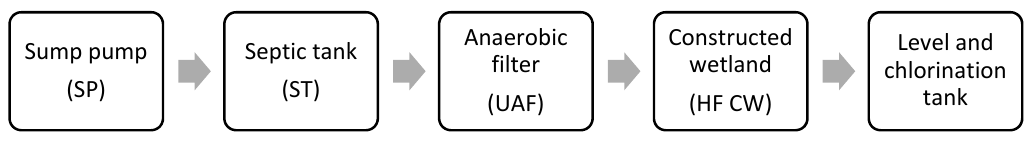
Figure 1. Block diagram describing the treatment process.